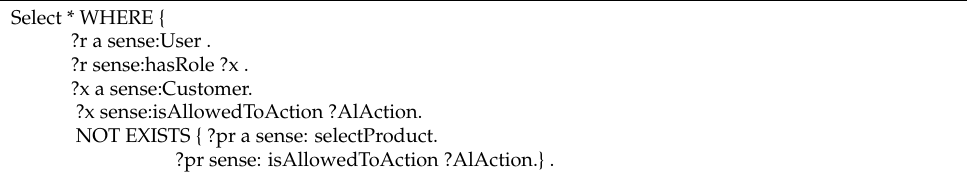
Table 10. SPARQL Query—Shopy use case.